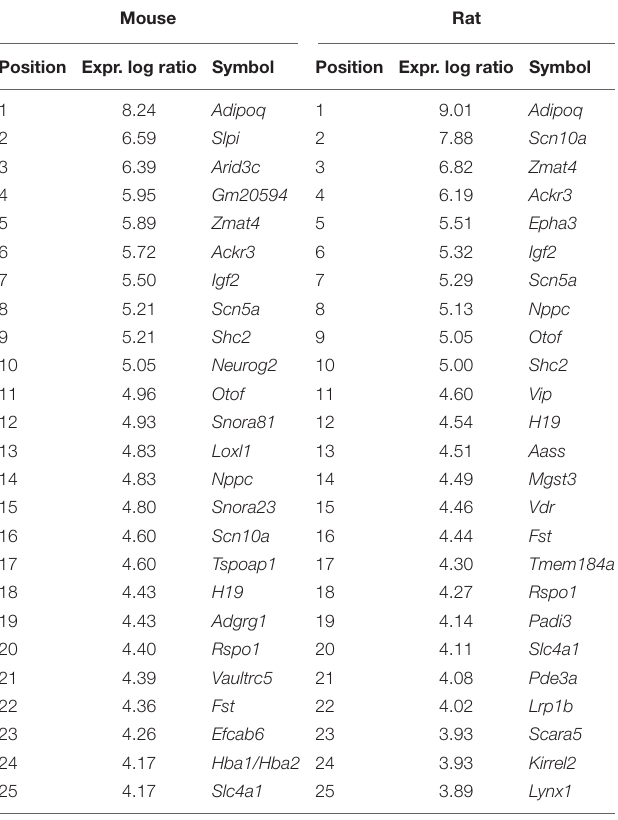
TABLE 2 | Top 25 significantly downregulated mouse and rat genes in response to neuronal differentiation of F11 cells. Mouse